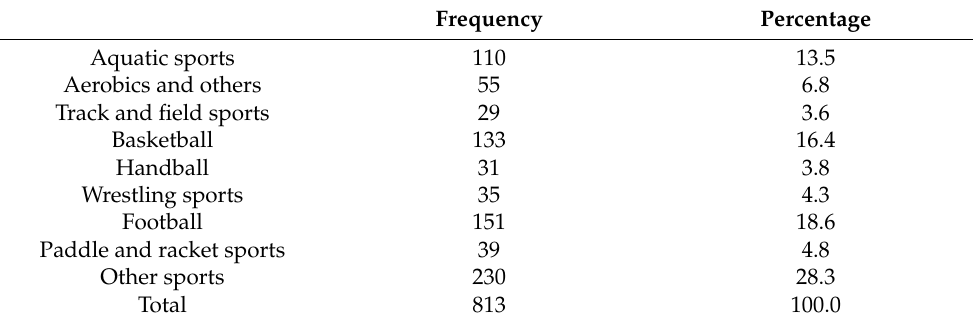
Table 5. Given the heterogeneity of the “Other Sports” category, the following comparative analyses do not take this category into account. Table 5. Categorization of sports practices.